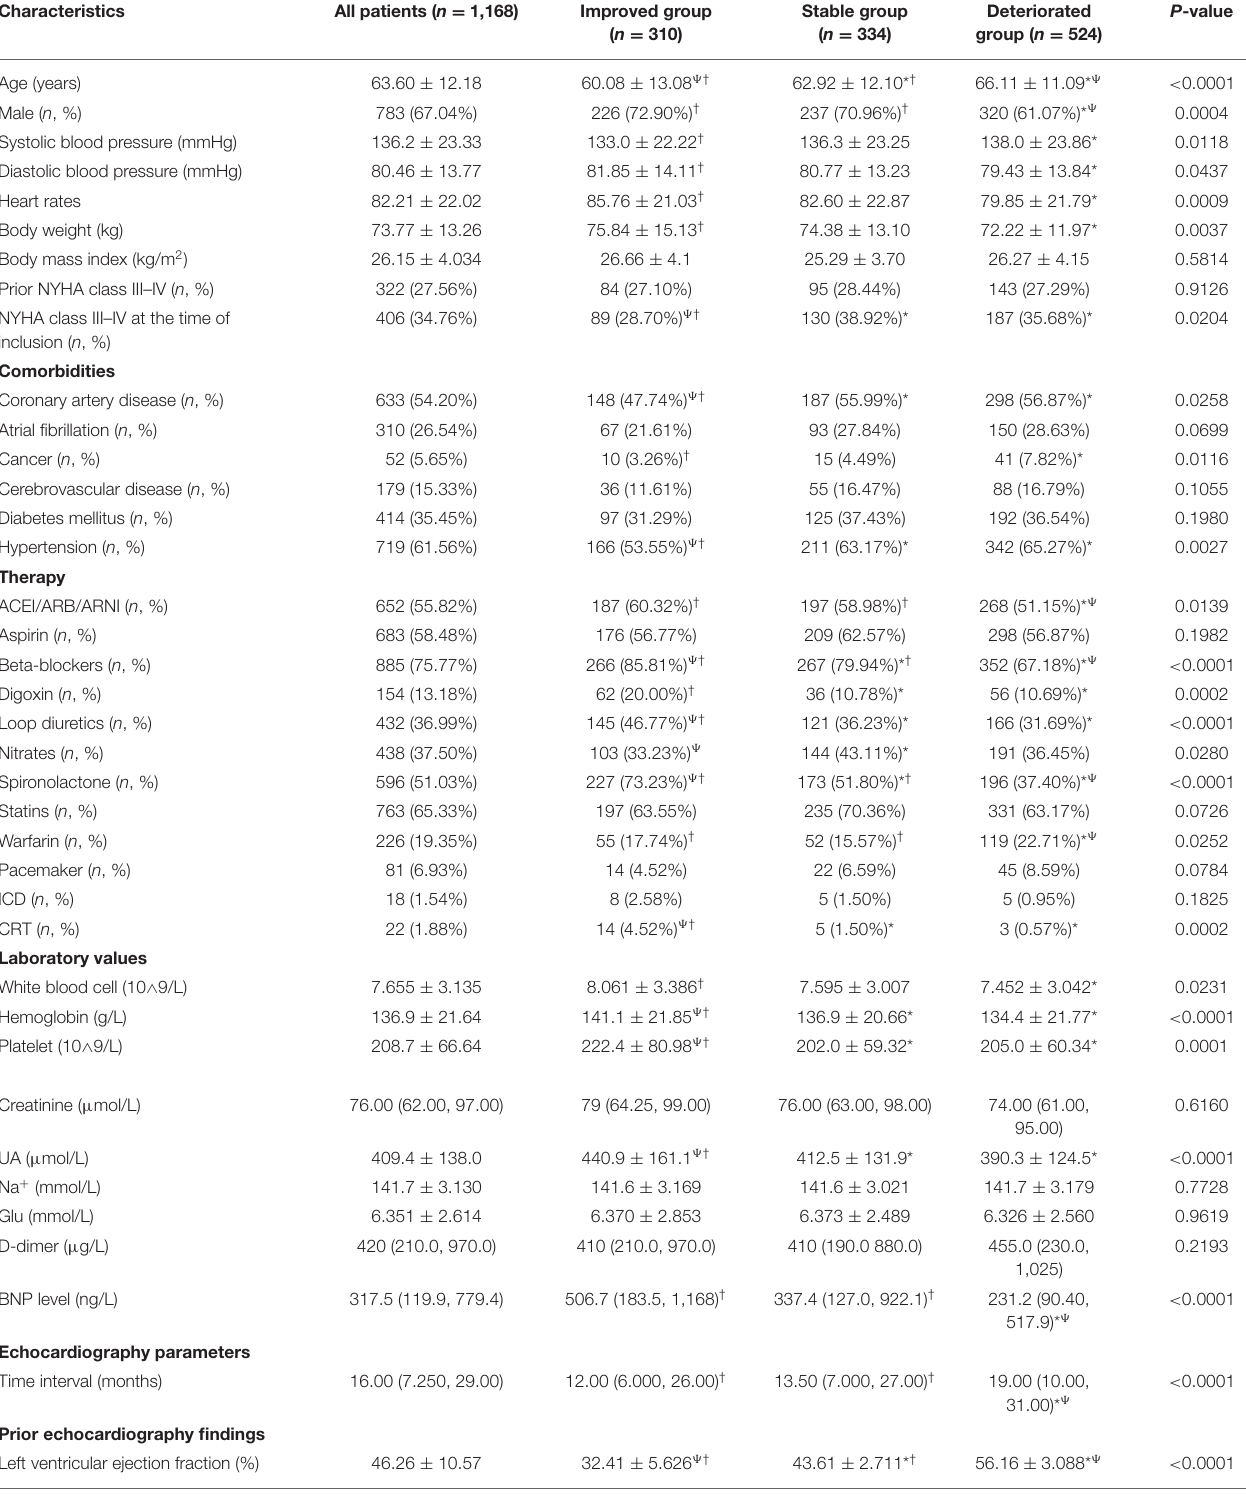
TABLE 1 | Baseline demographics and clinical characteristics of the enrolled heart failure patients stratified by the directional change in LVEF.